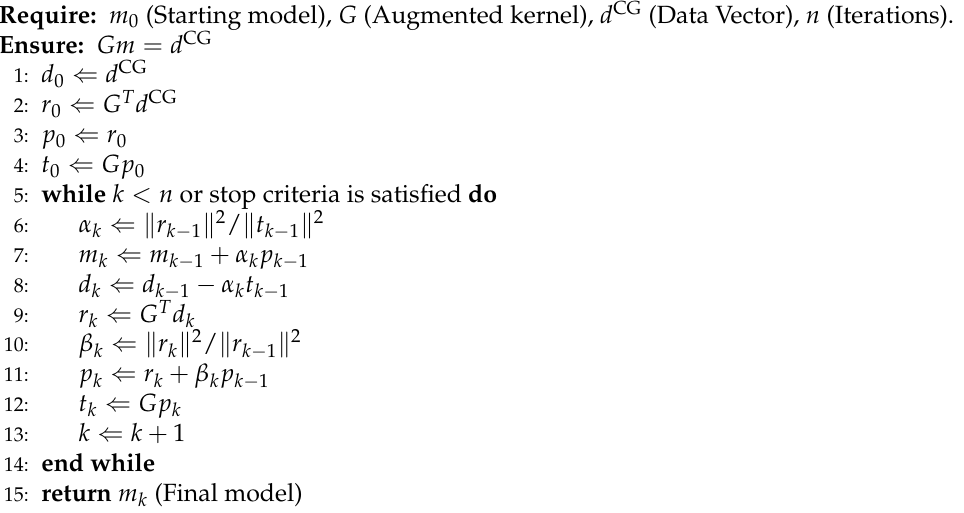
Algorithm 1 CGLS algorithm to iteratively solve the problem Gm = d